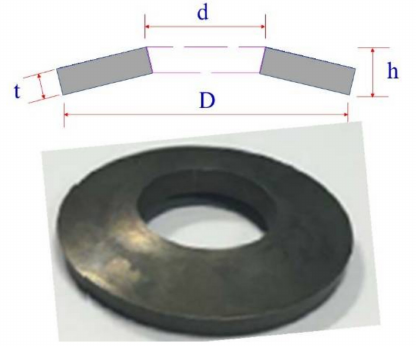
Figure 8. Configuration of a typical SMA washer.